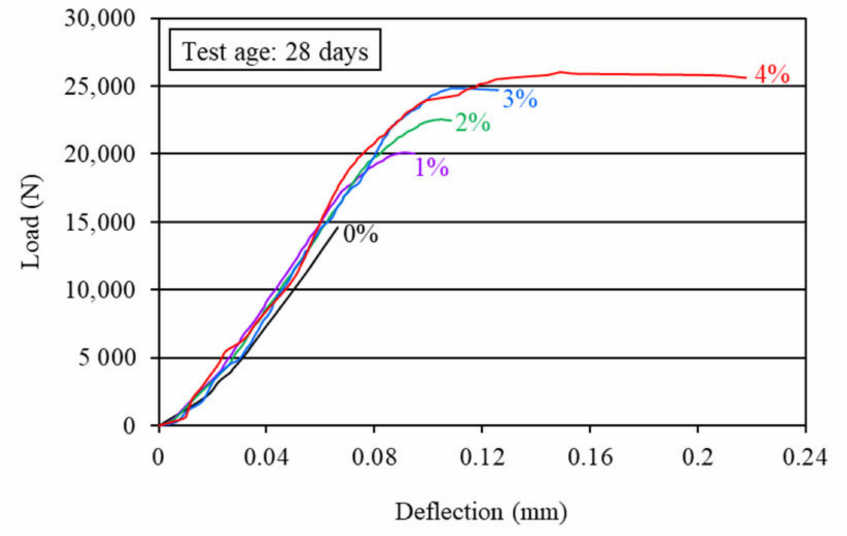
Figure 7. Characteristic flexural load-deflection behavior of the mortar composites at 28 days.